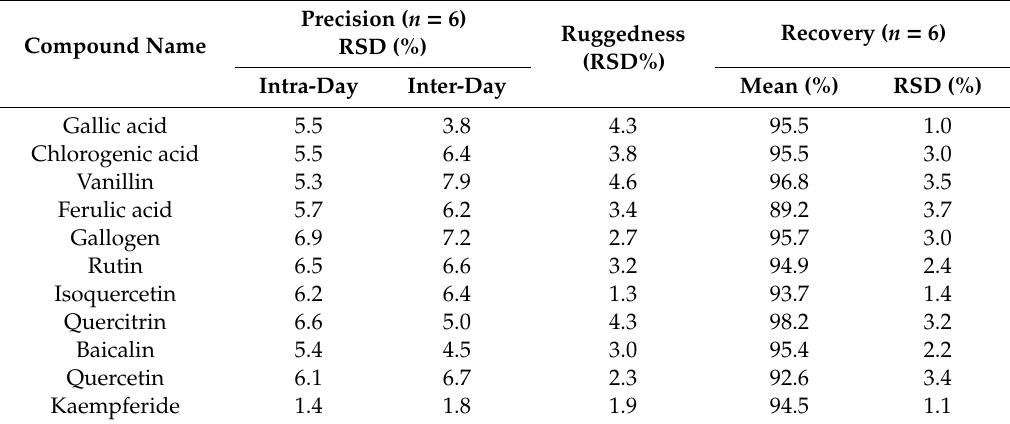
Table 3. The precision, recovery and ruggedness data for 11 reference